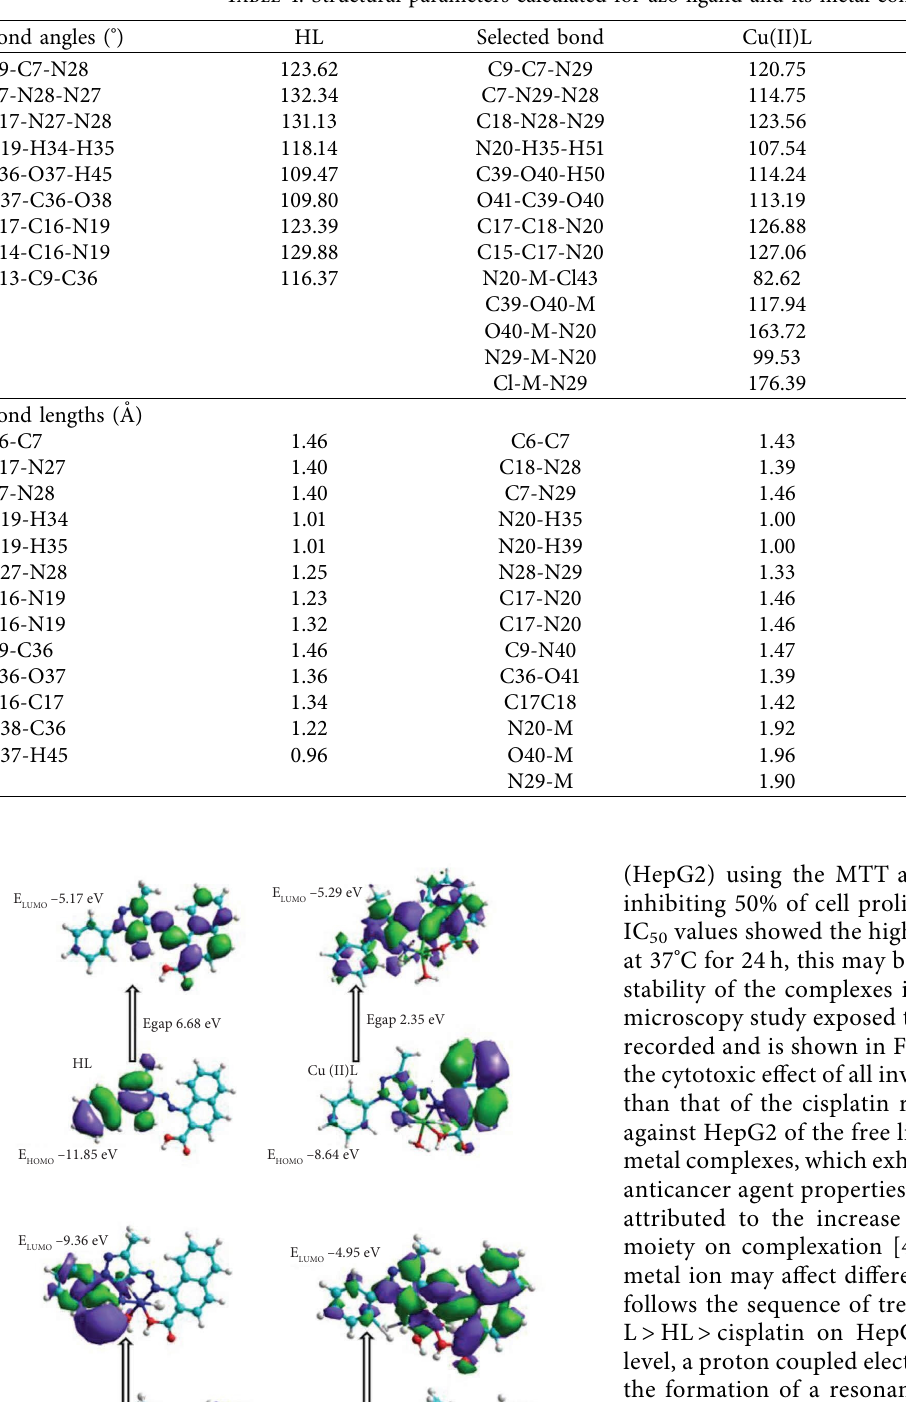
Table 4: Structural parameters calculated for azo ligand and its metal complexes.